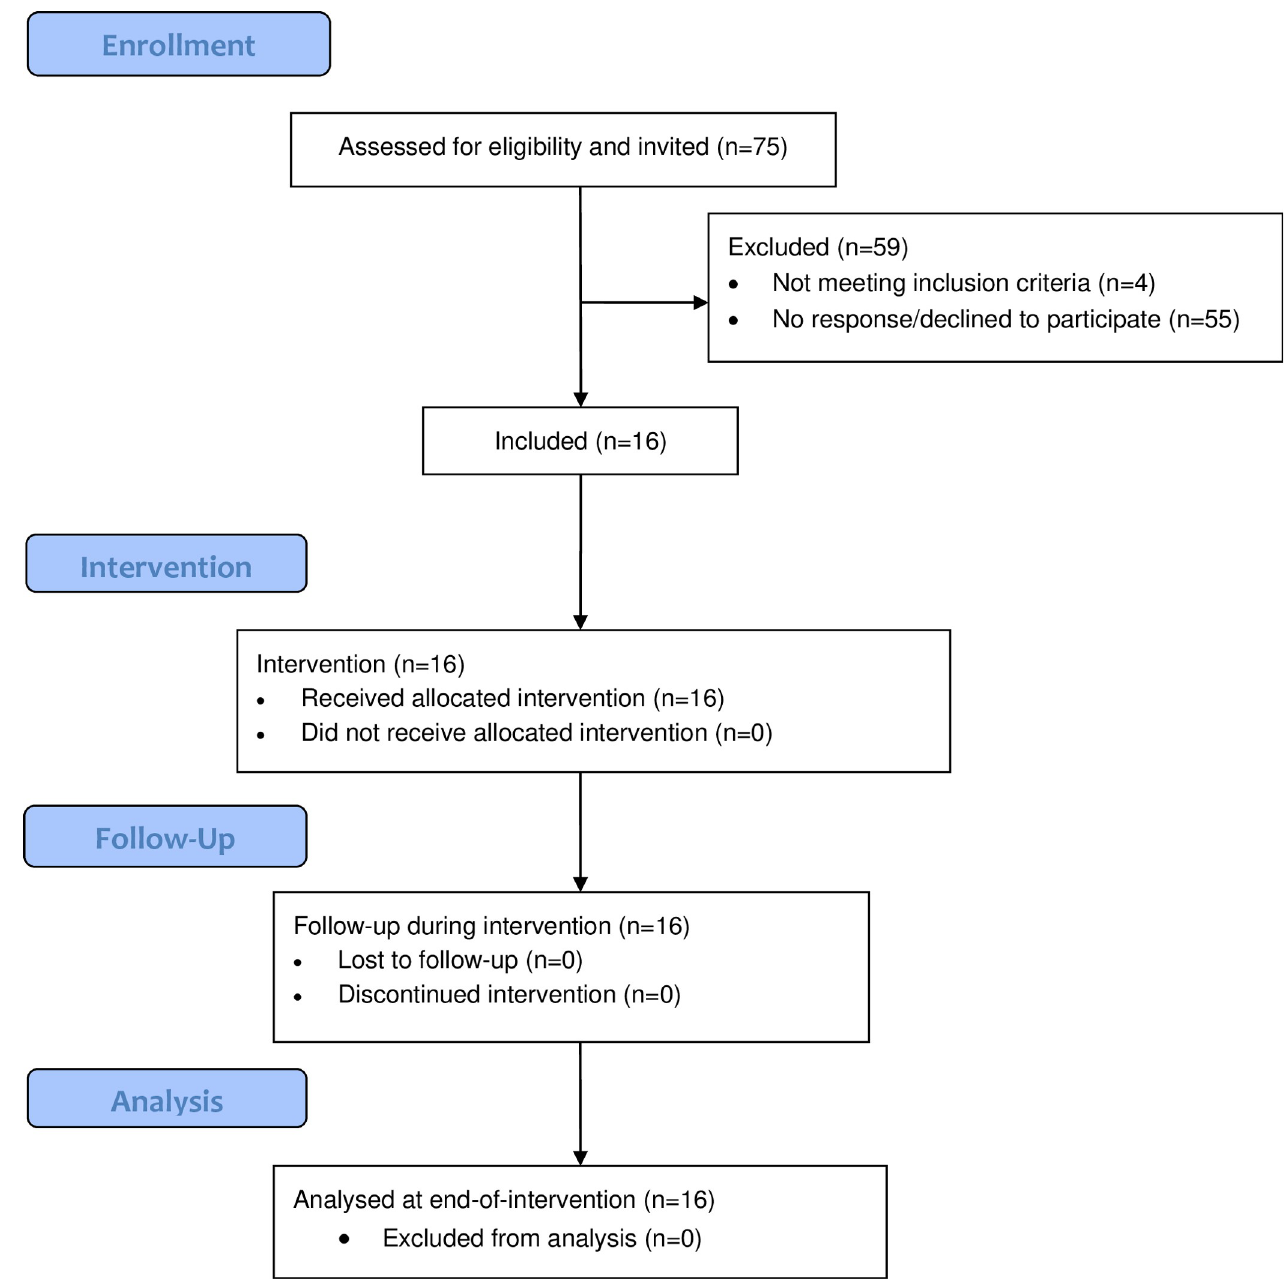
Fig 1. CONSORT flowchart (modified to fit a non-randomized pilot study). The RESTART pilot study 2017–18.